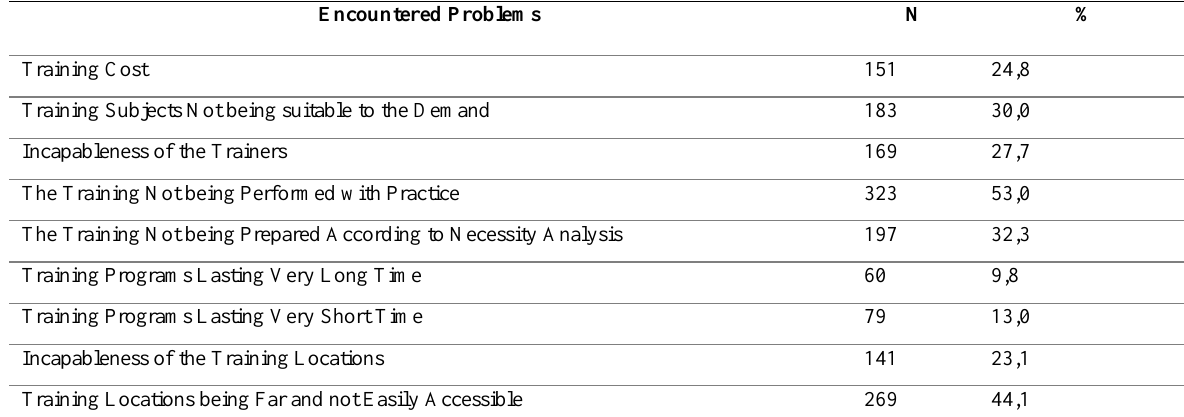
Table 12: Problems Encountered during Professional Service Training